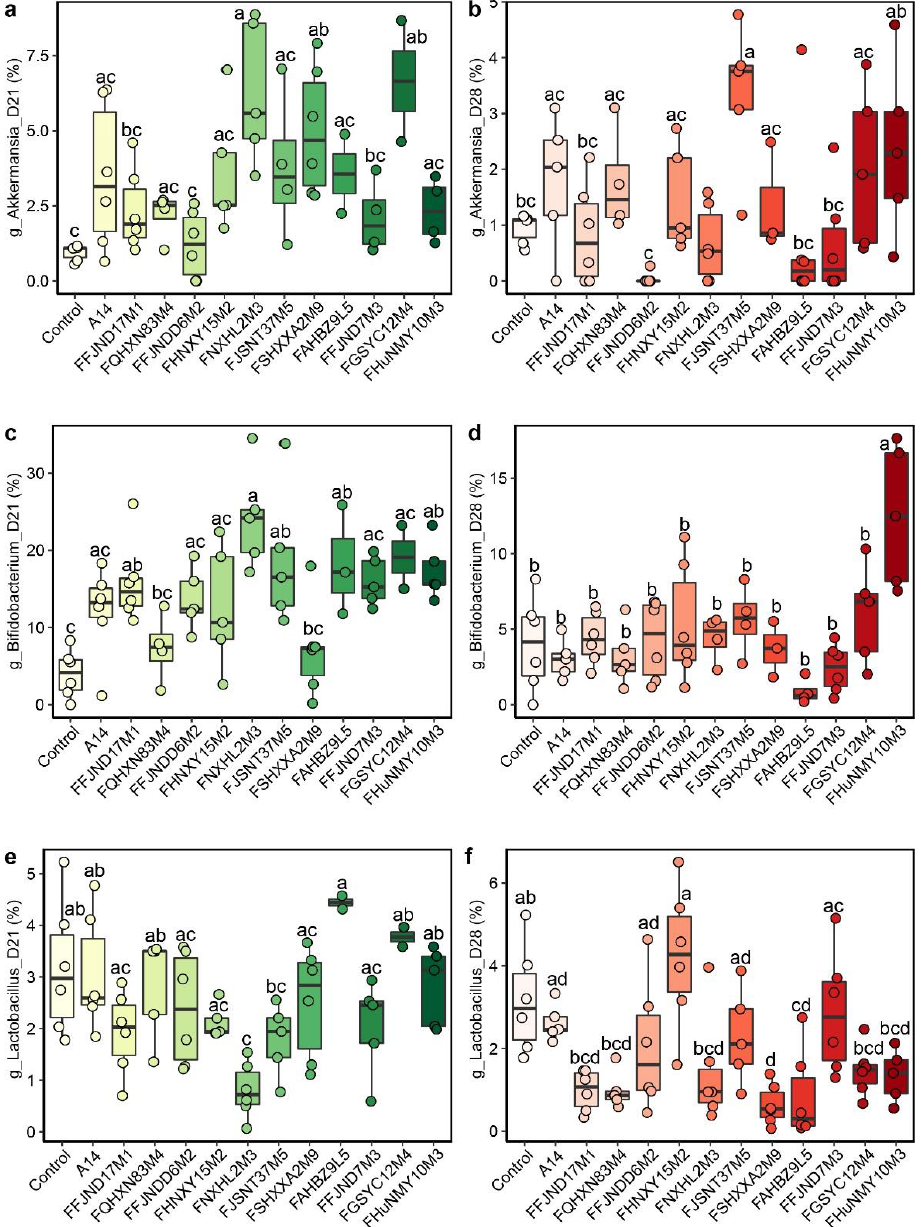
Figure 5. Comparison of different genus in fecal microbiota among groups of mice at different time points (D21, 21 days; D28, 28 days; the relative abundance of genus Akkermansia ( a , b ), Bifidobacterium ( c , d ), Lactobacillus ( e , f )). Different lowercase letters mean that there is a statistically significant difference between 13 groups at a probability level of p <